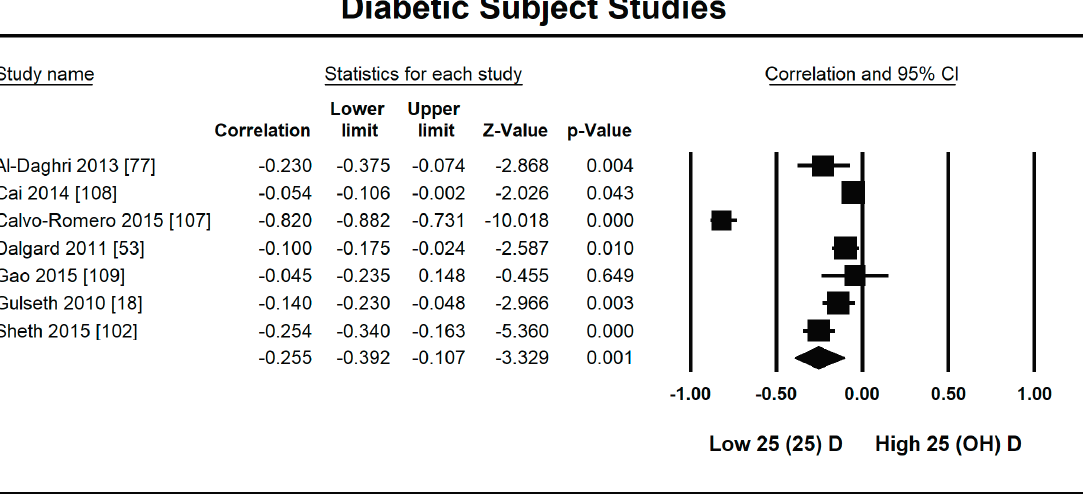
Figure 10. Forest plot for diabetic subject studies showing the correlation between status of vitamin D and fasting plasma insulin. The random effects model was used for the determination of correlation and 95% CI [18,53,77,107–109].